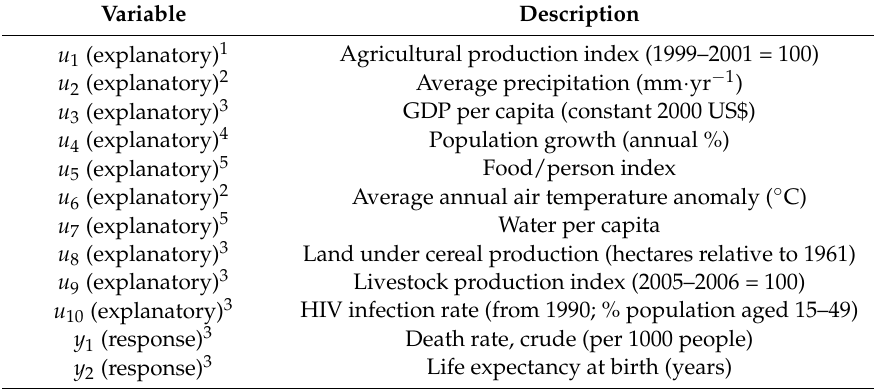
Table 1. Variables used in this